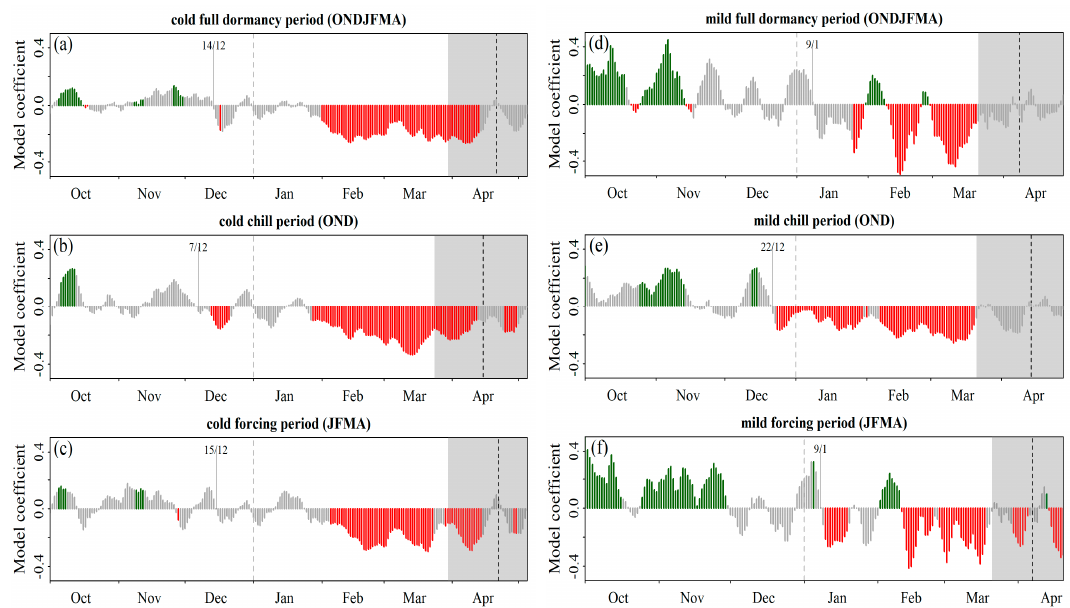
Figure 5. Results of the PLSR analysis for ‘Conference’ pear for the start date of flowering (BBCH61). Green and red areas depict coefficients of predictors (11-day running mean average daily temperature values) where the variable importance of the projection (VIP) value exceeds the threshold of 0.8, indicating that the corresponding variable is important for the model. Years have been separated in cold (left) and mild (right) halves based on average temperature during either the full dormancy phase (October to April ( a , d )); the chilling phase (October to December, ( b , e )); or the forcing phase (January to April, ( c , f )). The shaded area represents the range of observed bloom dates and the black dashed line within the shaded area its median value. The grey dashed line represents the first of January as reference. Labelled dates indicate the beginning of the forcing period.